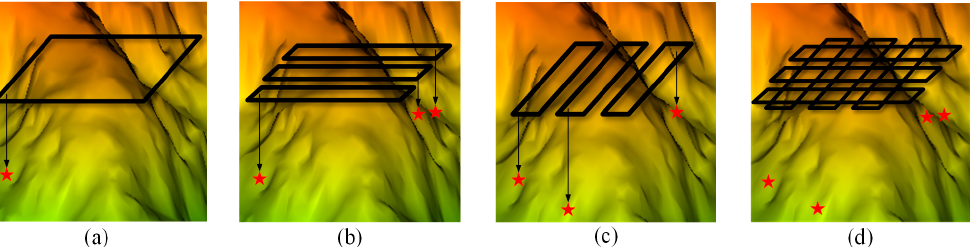
Figure 1. Conceptual diagrams of ground seed identification by using different windows: ( a ) square window; ( b ) narrow rectangle window in east–west direction; ( c ) narrow rectangle window in north–south direction; ( d ) multi-directional narrow rectangle window. Parallelogram boxes repre- sent windows, and red pentagrams are ground seeds that are identified by selecting the lowest points within the windows.